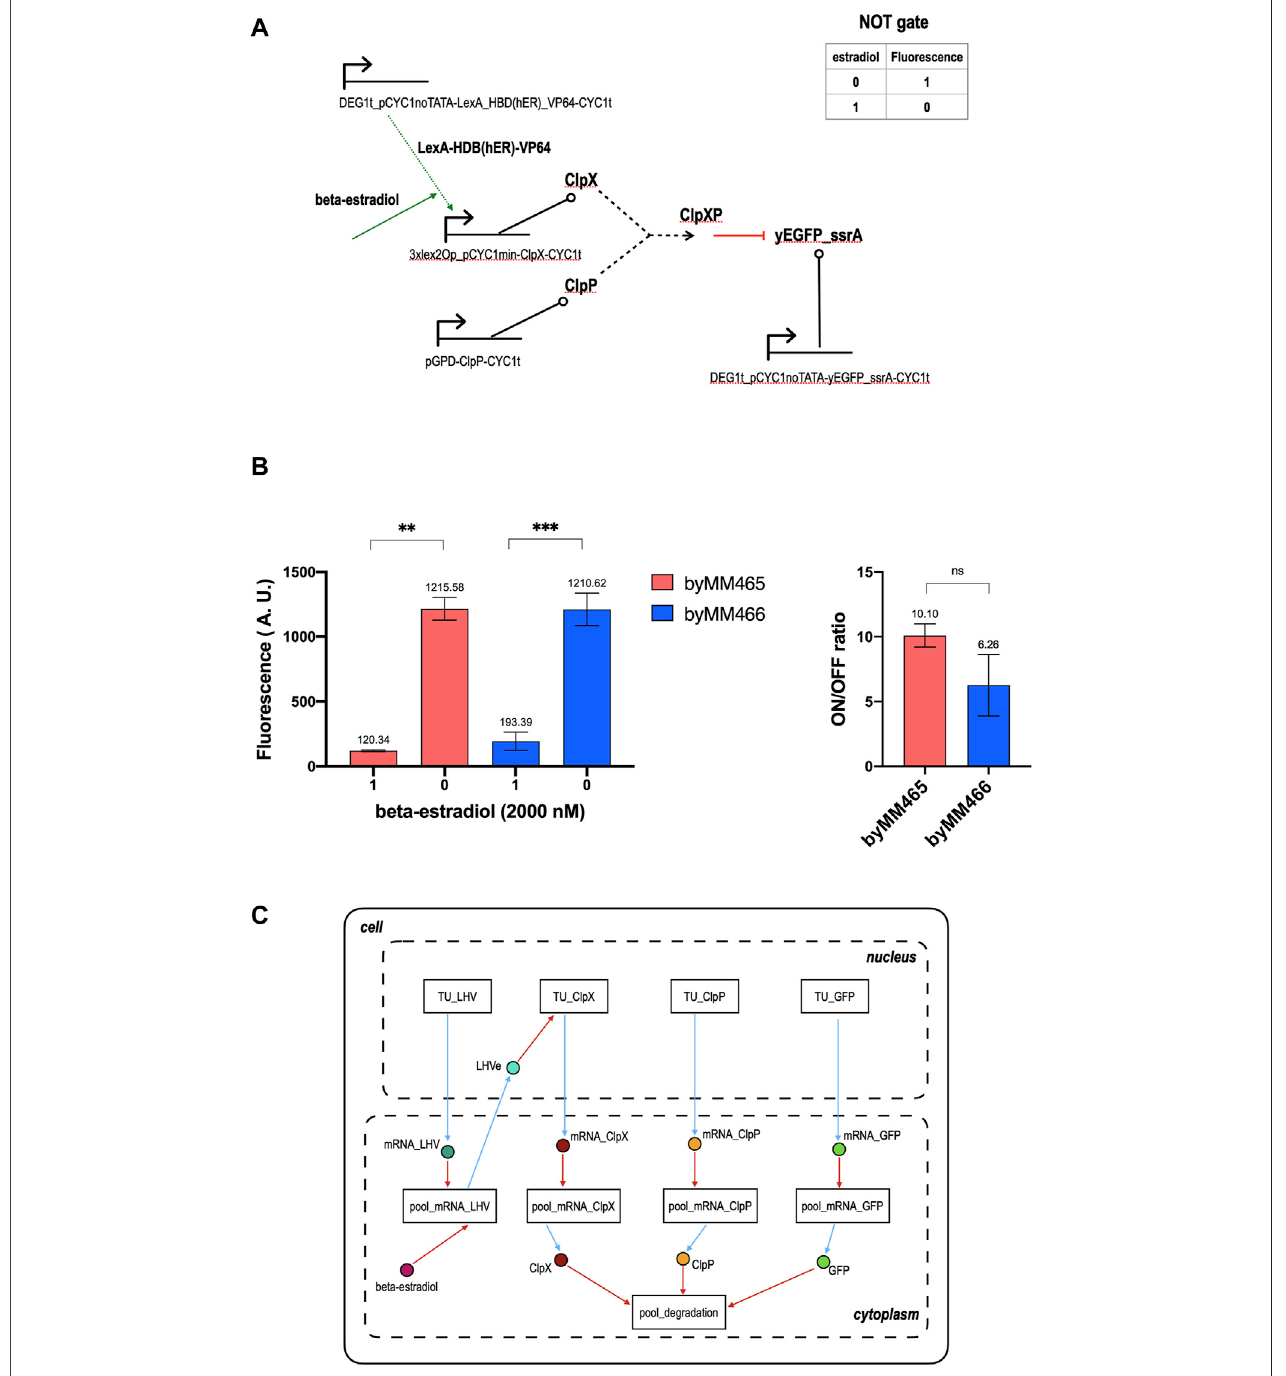
FIGURE 3 | NOT gate sensing beta-estradiol. (A) Circuit scheme. The synthesis of ClpX depends on the presence of the hormone beta-estradiol, the gate input. The additional TU with respect to the gate in Figure 1 synthesizes, constitutively, a chimeric activator that, in our model, we called LHV since it consists of the bacterial proteinLexA(actingasaDNA-bindingdomain),thehormone-bindingdomainofthehumanestrogenreceptor(HBD(ER)),andtheviralstrongactivationdomainVP64.In the absence of beta-estradiol, LHV is kept in the cytoplasm because of the action of Hsp90 that binds HBD(hER). As a consequence, the synthetic activated promoter upstream of ClpX, which is made of three copies of lex2Op (the LexA operator) in front of a minimal weak CYC1 promoter (Ottoz et al., 2014), is incapable of producing ClpX in high quantity such that the gate fl uorescent output is high. A concentration of 1-2 µM beta-estradiol, which bind HBD (hER), nulli fi es the effect of Hsp90 and lets the complex LHVe (LexA_HBD(hER)_VP64-beta-estradiol) get into the nucleus and enhance the synthesis of ClpX, upon binding the three lex2Ops upstream of pCYC1min. Under these conditions, ClpX is highly expressed and, as a consequence, the fl uorescence emitted by the gate drops to a very low level. (B)